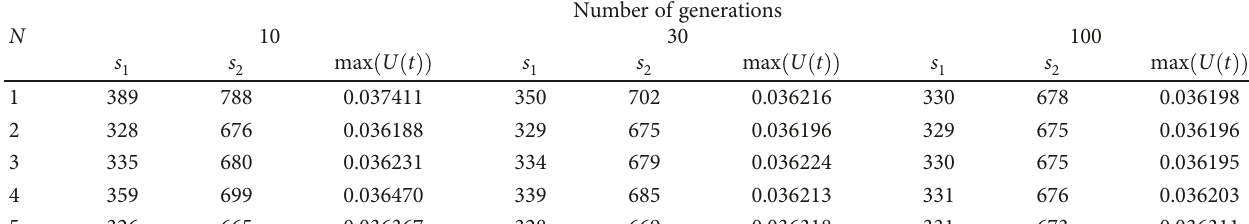
by GA. 1 and s ( μ m) by minimizing the amplitude of the signal (max( U ( t )) (V)) at the three-conductor 1 2